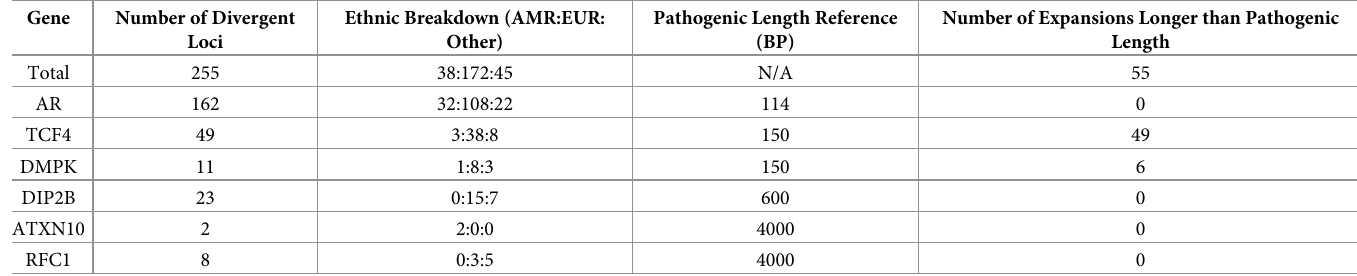
Table 3. STR expansions in pathogenic loci within proband